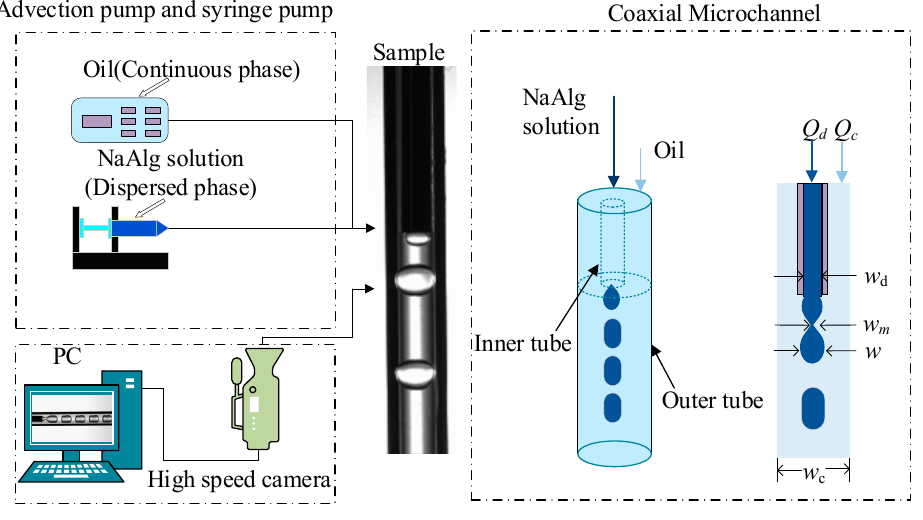
Figure 1. The schematic diagram of experiment devices.